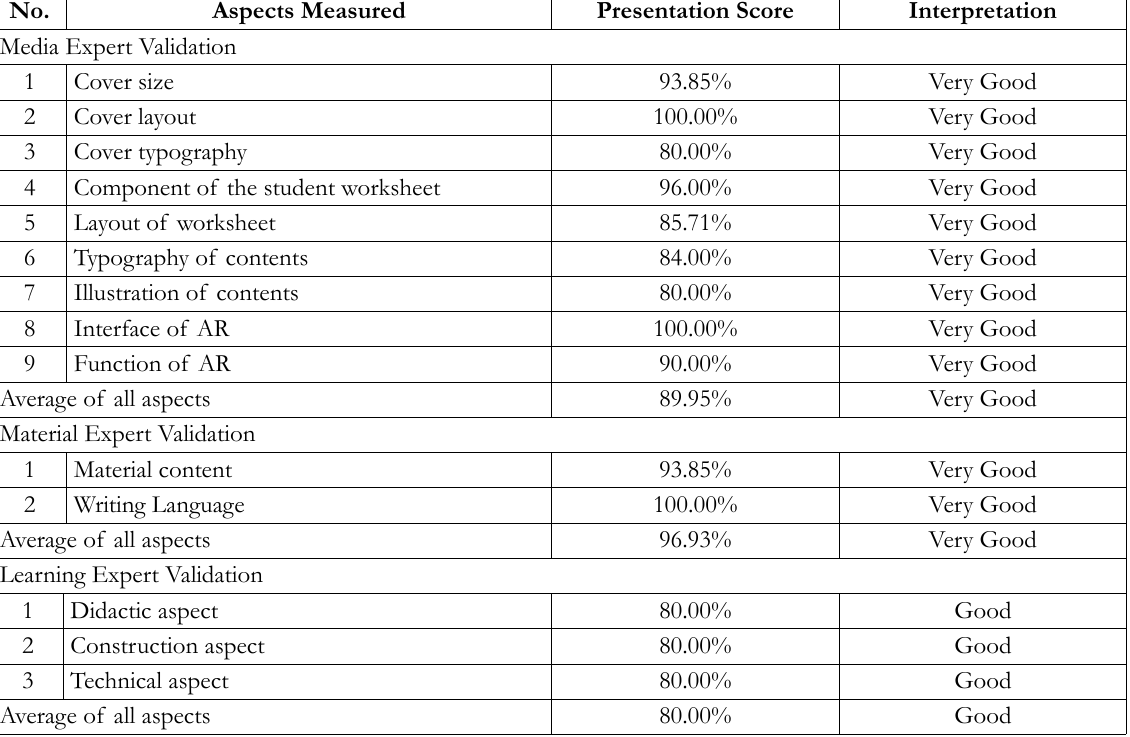
Table 3. The validation results of media experts and learning